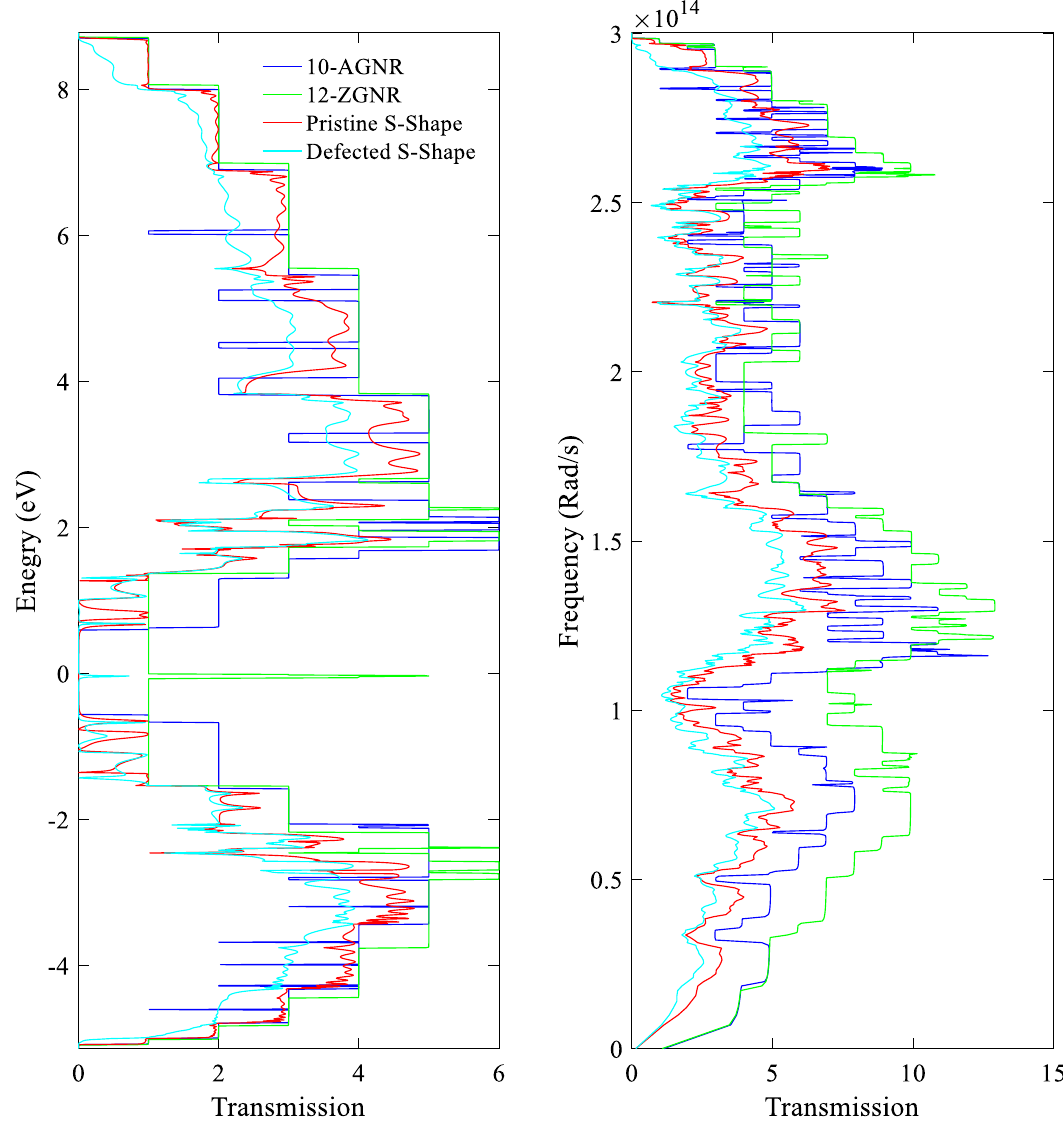
Figure 7. ( a ) Transmission spectra for electrons, and ( b ) for phonons in the 10-AGNR (indicated by blue), 12-ZGNR (green), pristine S-shape (red), and the defected S-shape structure with L D